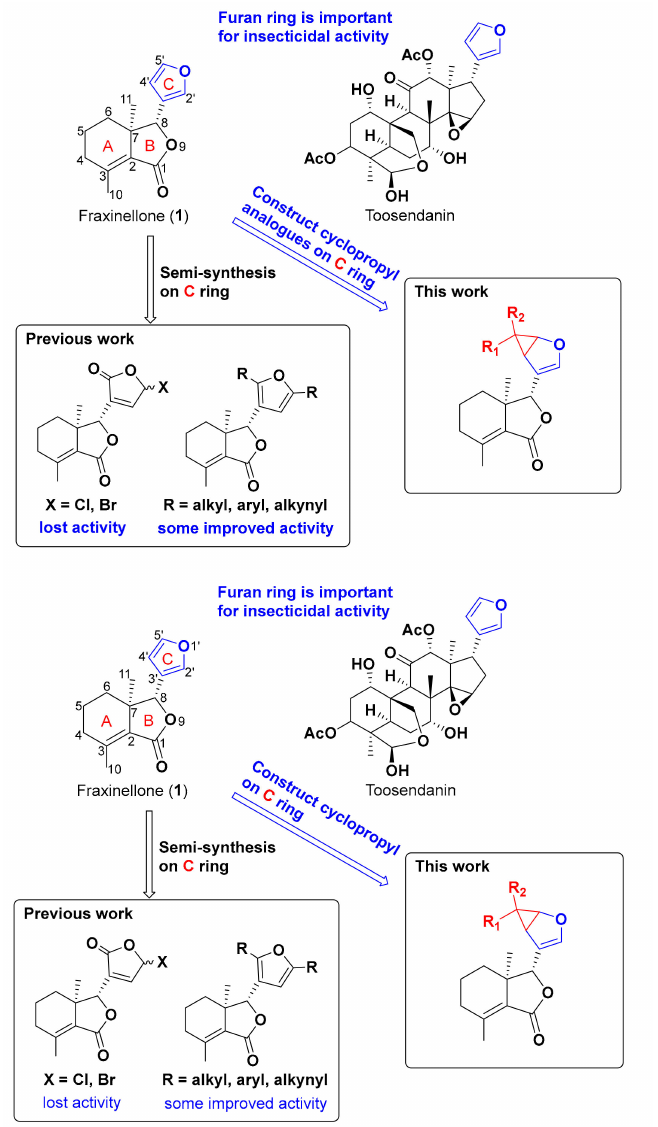
Figure 1. Chemical structures of fraxinellone ( 1 ) and its furan-modified analogues, and